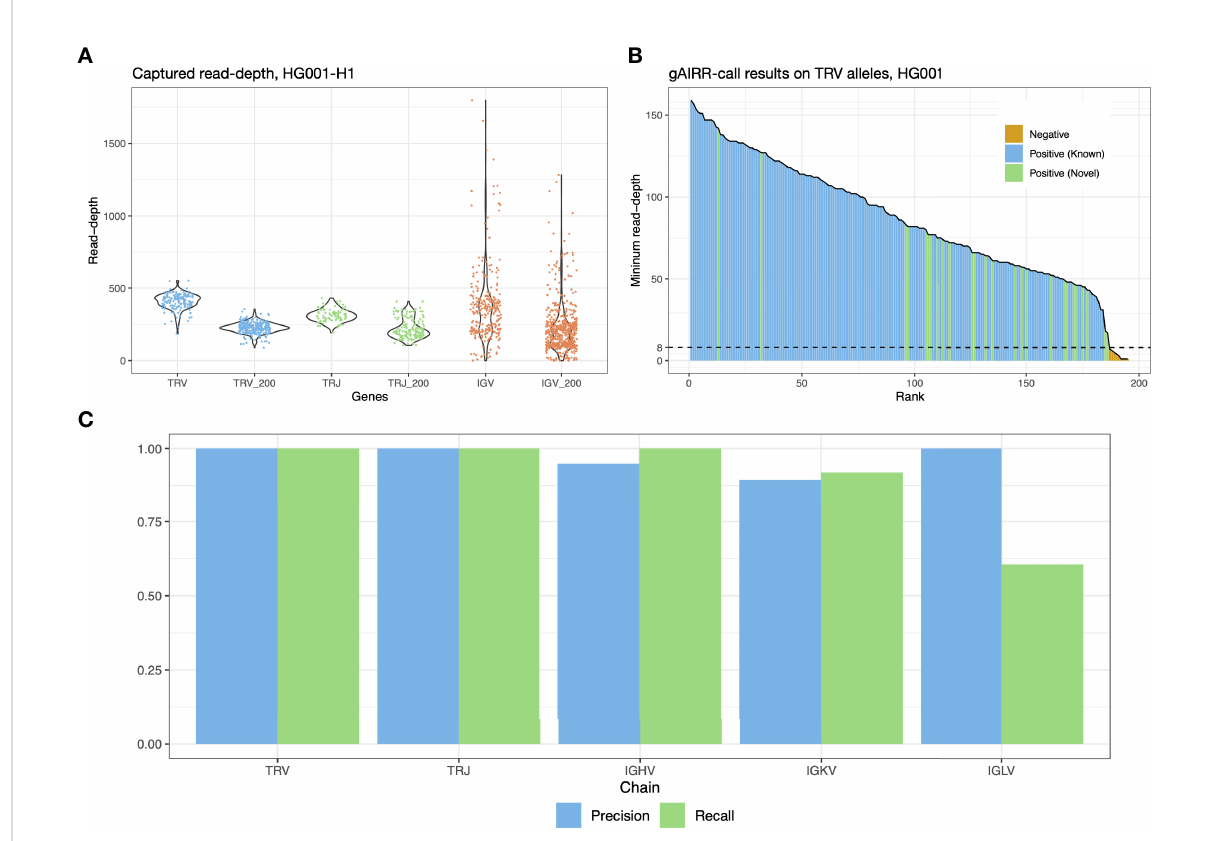
FIGURE 2 gAIRR-seq and gAIRR-call results. (A) Read depths sequenced with gAIRR-seq in TRV, TRJ and IGV regions using data from HG001. Columns without the “ _200 ” suf fi x shows the average read-depth of a region. Columns with the “ _200 ” suf fi x shows the read depth 200 bp away from the region boundaries. (B) gAIRR-call results using HG001 data. The results are sorted by minimum read-depth of the perfect matched reads. The dash line represents the adaptive threshold in gAIRR-call. All the alleles not annotated by gAIRR-annotate, colored in orange, are below the adaptive threshold and are regarded as nocalls by gAIRR-call. True known alleles are in blue and true novel alleles are in green. In the HG001 analysis all true alleles are successfully identi fi ed by gAIRR-call. Alleles with zero minimum read-depth are not included in the fi gure. (C) gAIRR-call concordance with manual inspected gAIRR-annotate results for HG001. For IGHV, IGKV, and IGLV regions, we only included the functional